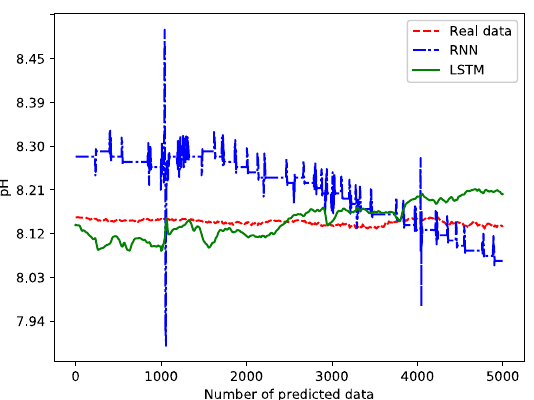
Figure 17. Comparison of RMSE for pH.